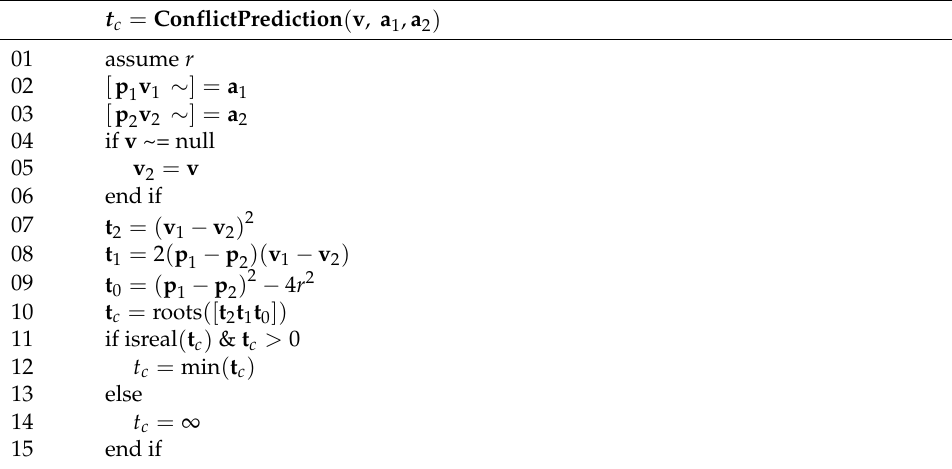
Table 2. Conflict prediction between two UAVs.